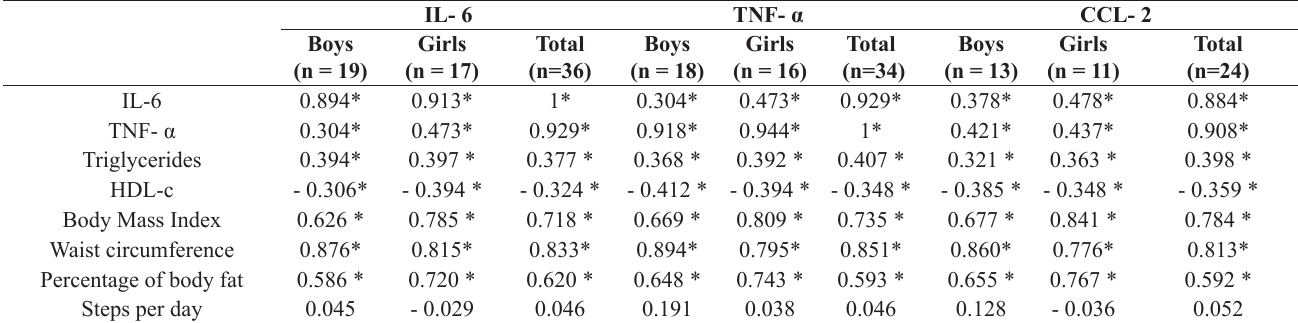
Table 3. Correlation between inflammatory biomarkers, triglycerides and HDL-c, anthropometric measures, body composition and physical ac- tivity